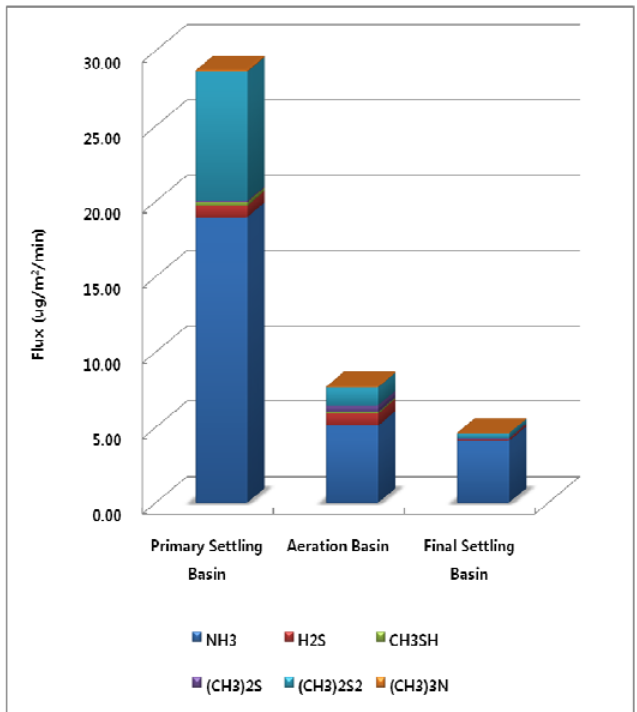
Figure 4. Annual Odorous Compounds Emission Flux from each Treatment